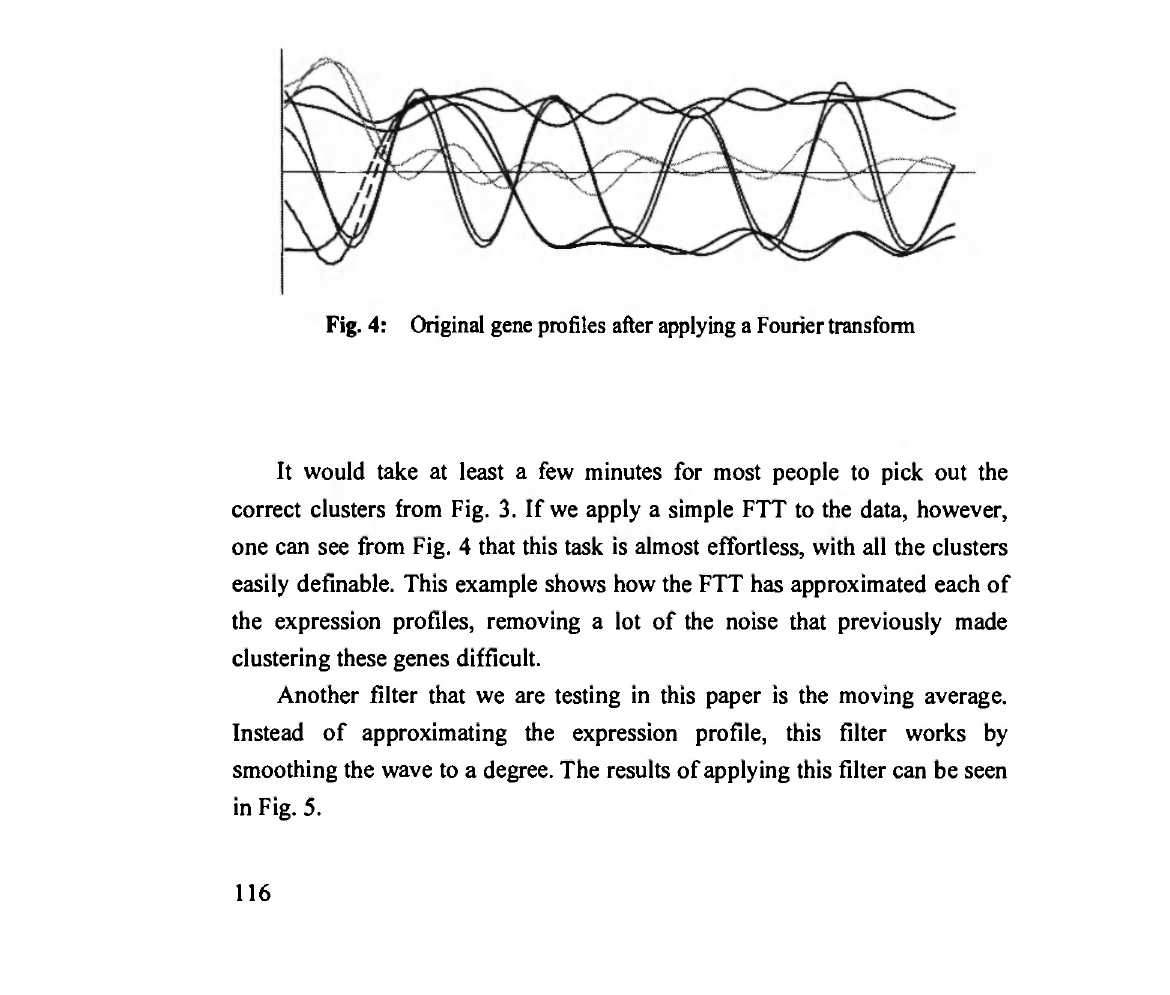
Fig. 3: Eight original gene profiles